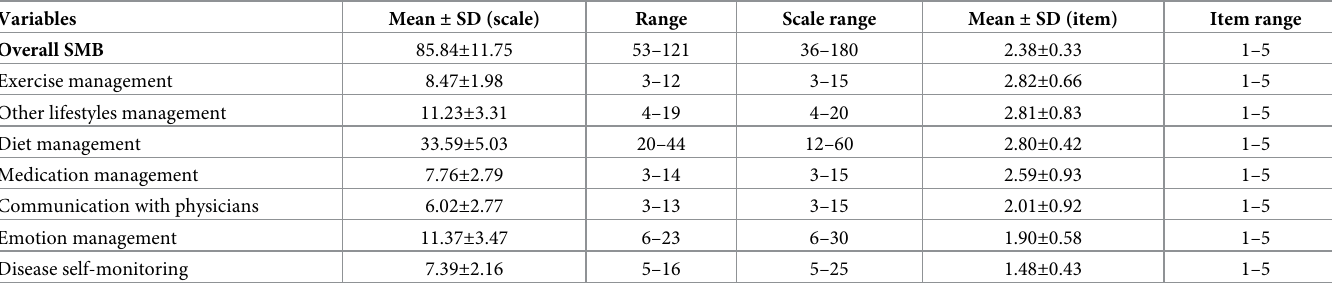
Table 2. Overall health self-management behaviour scores of Kazakh MS patients ( n =